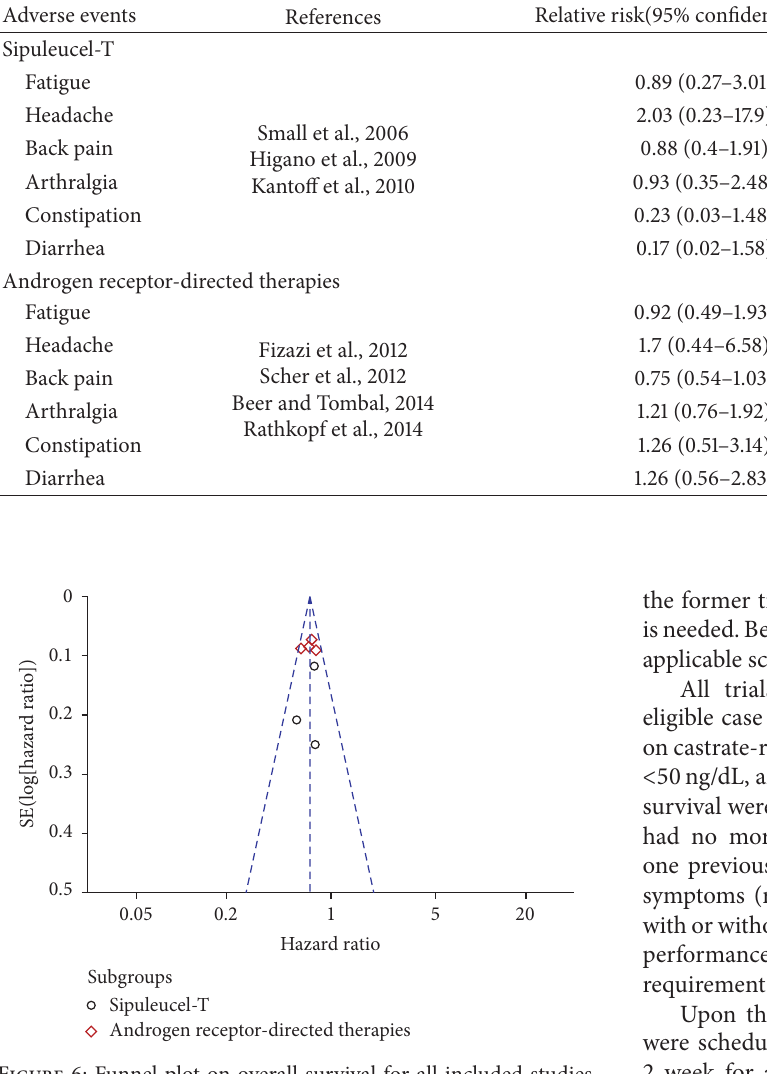
Table 3: Analyses of adverse events (grade ≥ 3).